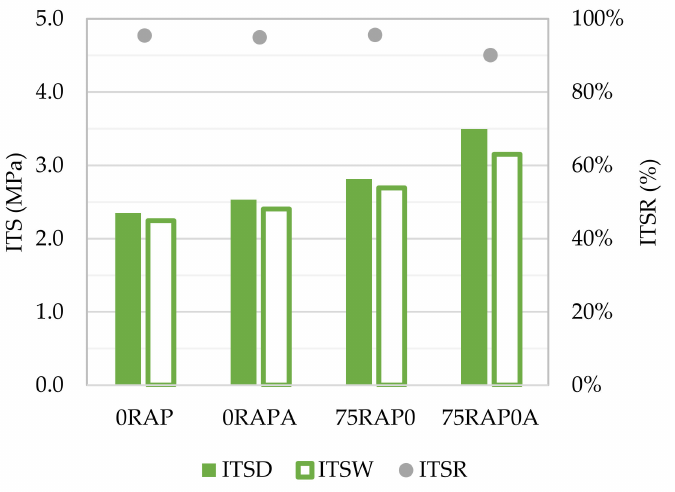
Figure 9. Resistances to moisture